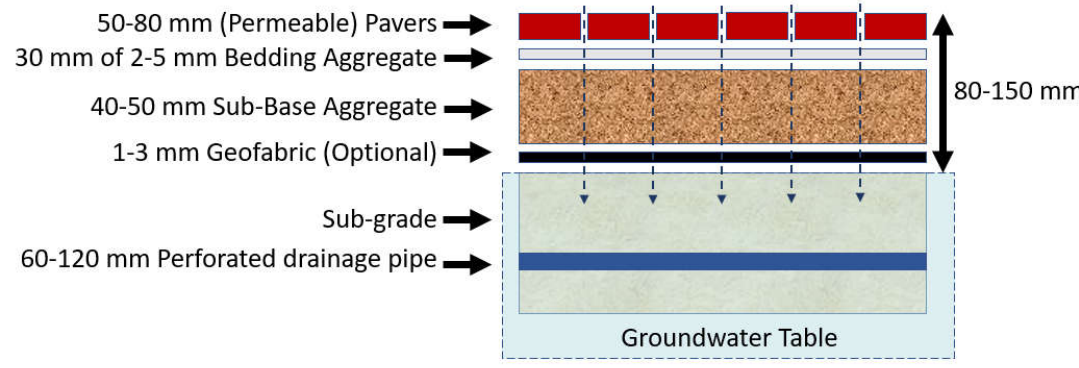
Figure 2. Typical (Dutch) permeable pavement structure.